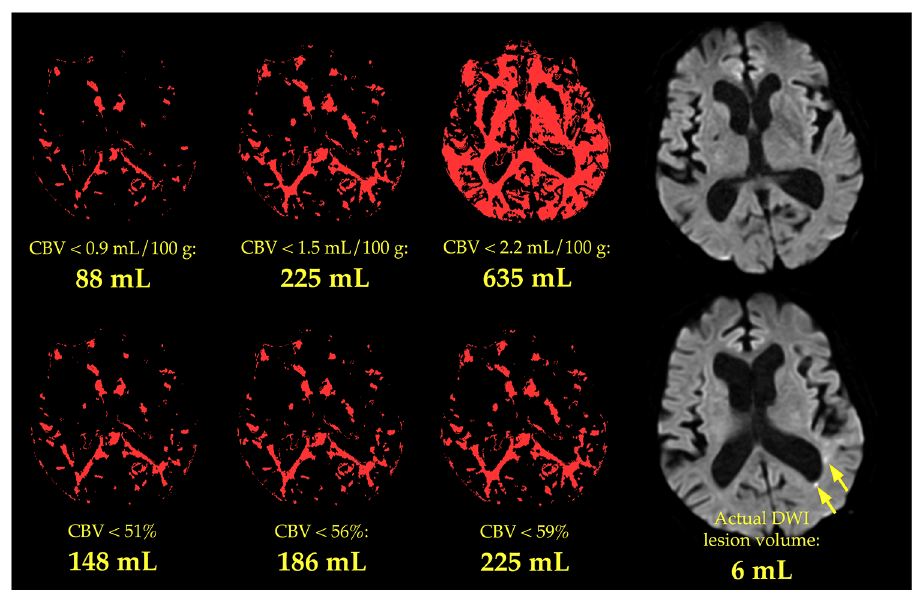
Fig 3. Objective measurement of CBV lesion volume in a second patient. The six smaller images depict low-CBV lesions that were delineated automatically, in a single slice of a second patient ’ s CBV maps, by rendering in white all brain pixels in which CBV was below each of six different thresholds. Each threshold is listed below its corresponding image, along with the total volume of tissue with CBV below that threshold in all slices. For clarity, the lesions identified by only three of the six absolute thresholds are shown in the top row, and lesions identified by only three of the six relative thresholds are shown in the bottom row. No lesions were seen in a DWI image acquired at approximately the same level (upper right), although DWI images acquired more superiorly showed several small lesions whose total volume was 6 mL (bottom right, arrows).